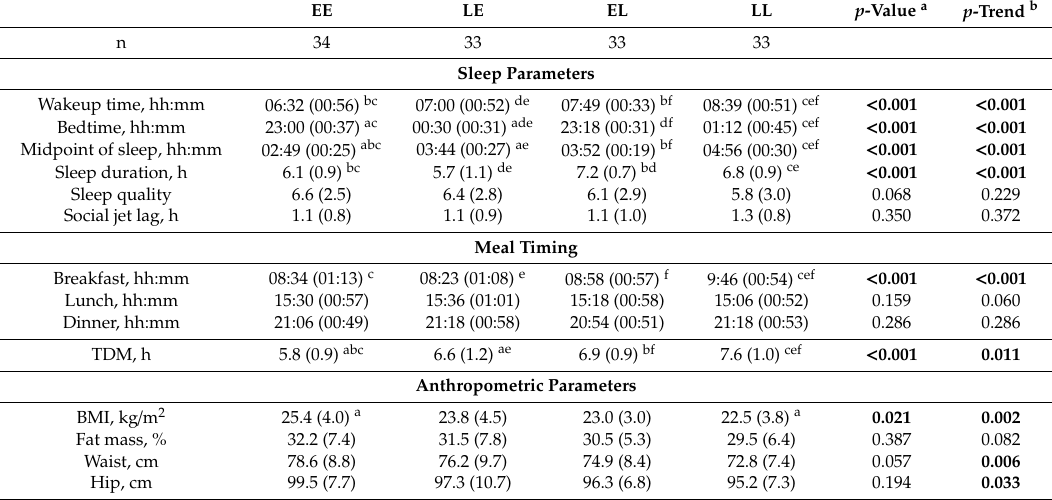
Table 1. Sleep- and circadian-related characteristics, anthropometric variables and dietary intake of the studied population grouped by sleep timing behavior. EE LE EL LL p -Value